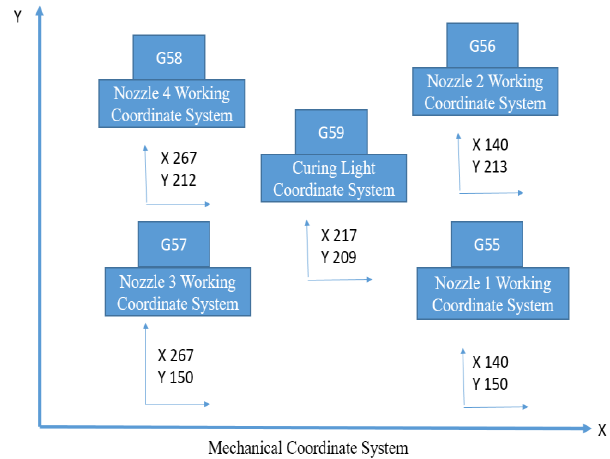
Figure 4. Multi-nozzle operating coordinate setting.